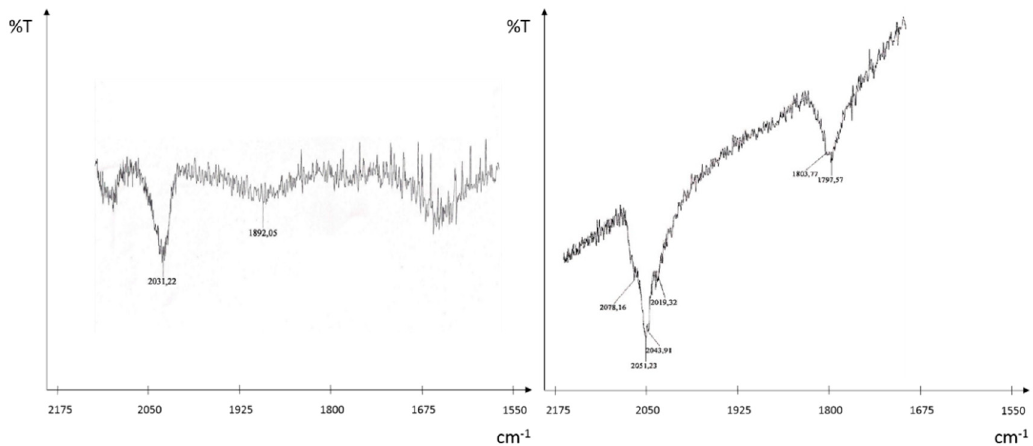
Figure 2. Solid-state infrared (IR) spectra of the bare (left) and Rh-deposited (right) CZOm support.